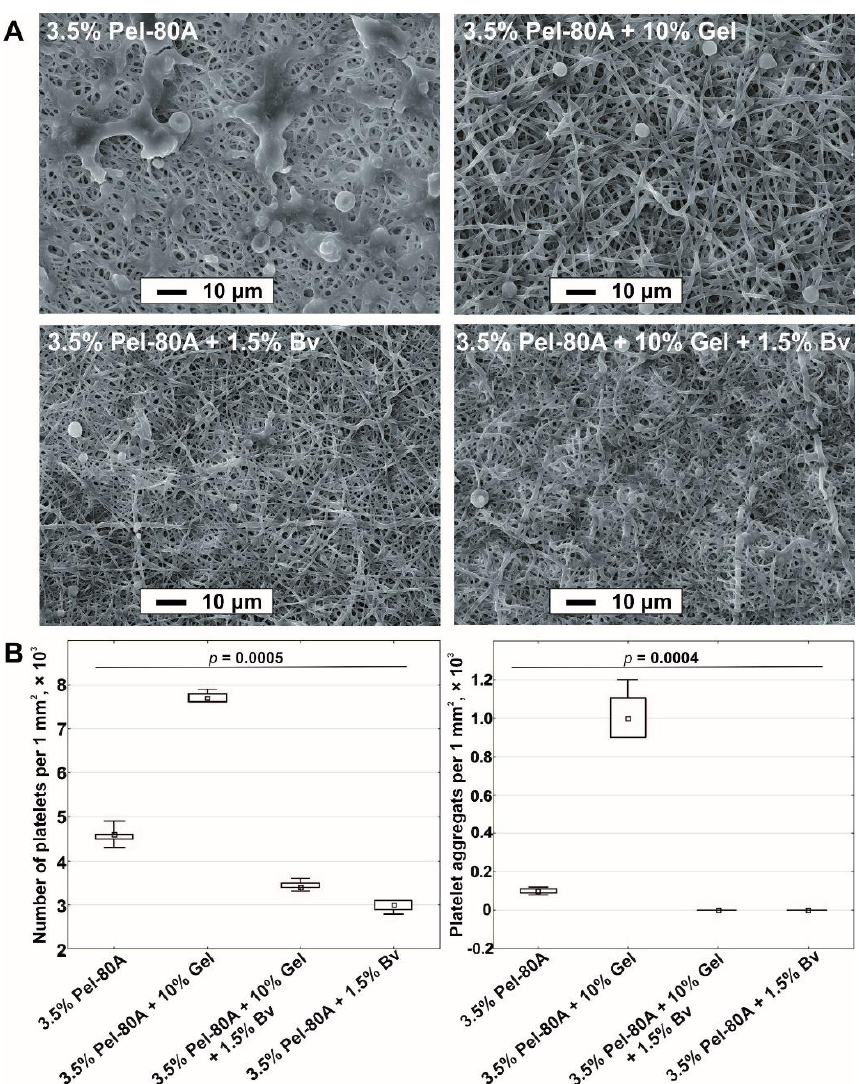
Figure 3. Blood contact test for different scaffolds. SEM images obtained after incubation of electrospun tubes with blood (scale bar, 10 μm; magnification, 1000×) ( A ). Quantitative data of adhered platelets and their aggregates on surface tubes are presented as a median and interquartile range ( B ). Table 2. Hemocompatibility of electrospun scaffolds.